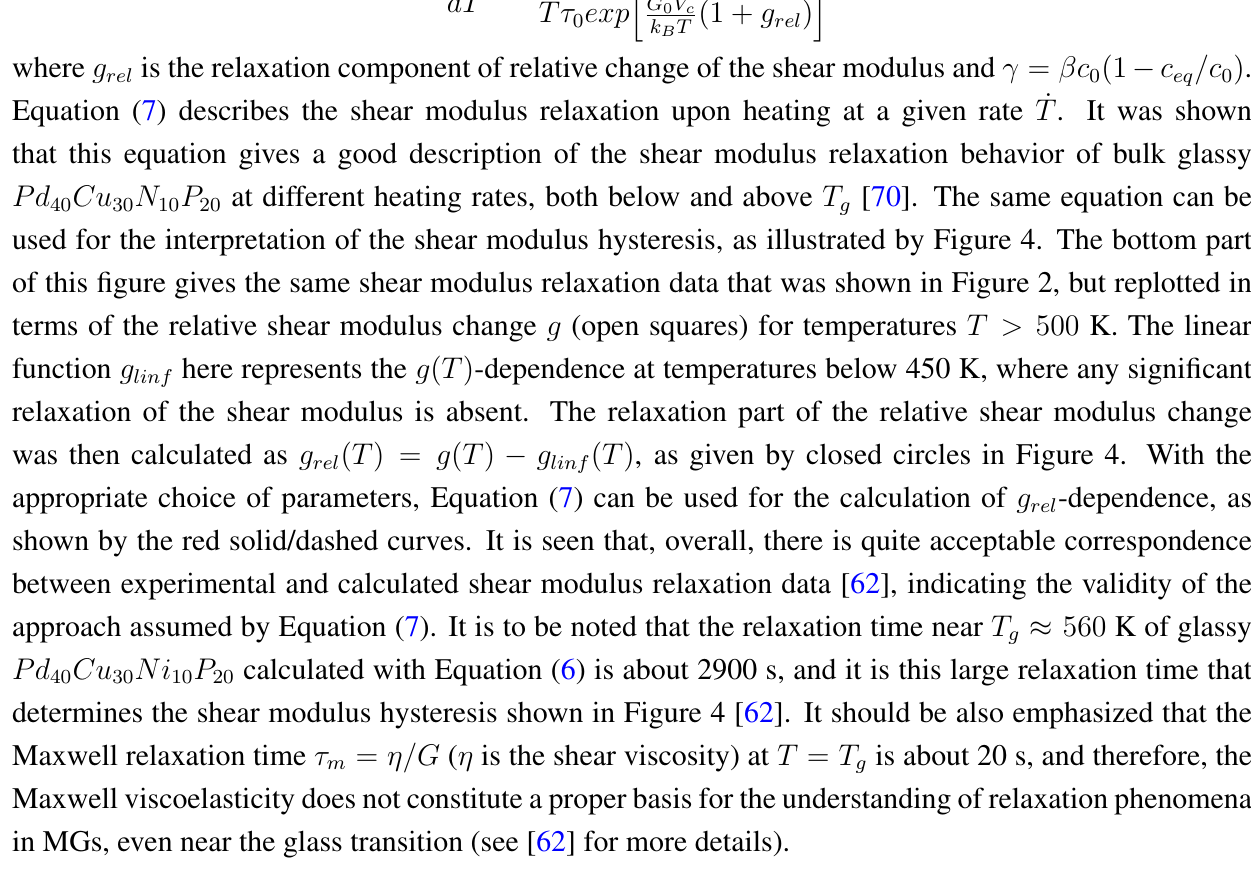
( T ) for temperatures T ≤ 450 K linf